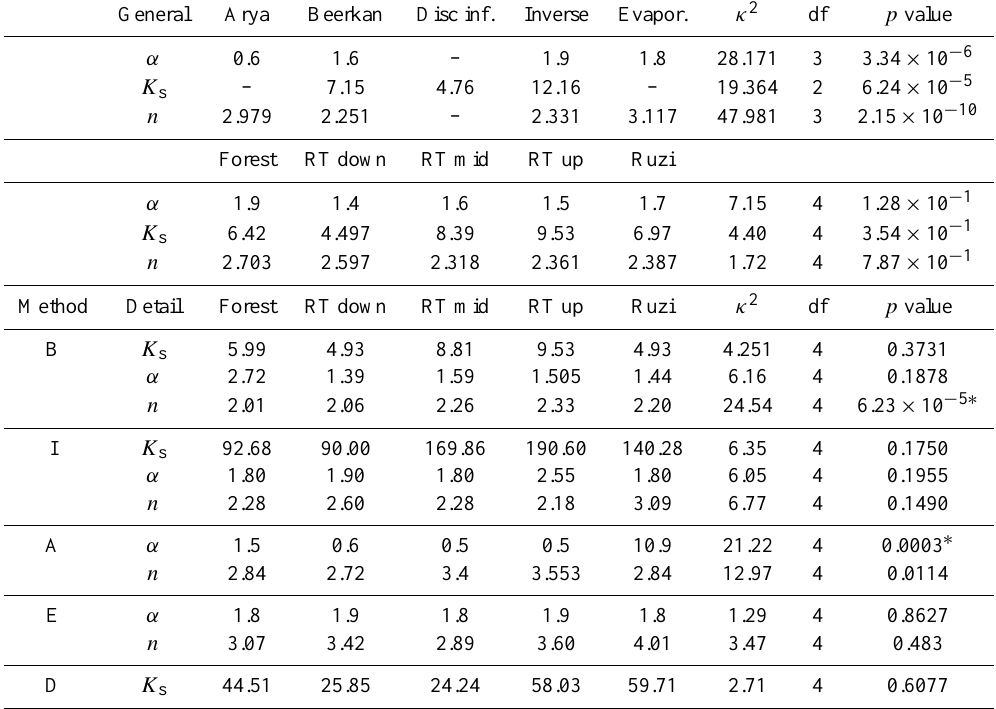
Table 4. Medians and parameters of Kruskal–Wallis, chi-squared ( κ 2 ), degree of freedom df, and p value for the van Genuchten parameters for different methods and different sites, in general and in detail for each method, K s × 10 − 6 (ms − 1 ) and α (m − 1 ). B: beerkan, I: inverse, A: Arya, E: evaporation, D: disc. ∗ indicates a statistically significant difference between values. General